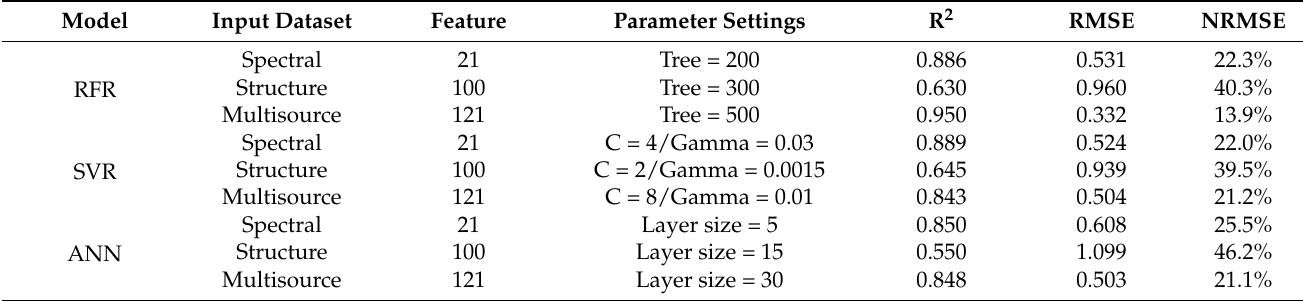
Table 5. Quantitative relationship between the LAI and measured values based on the machine learning models in experiment